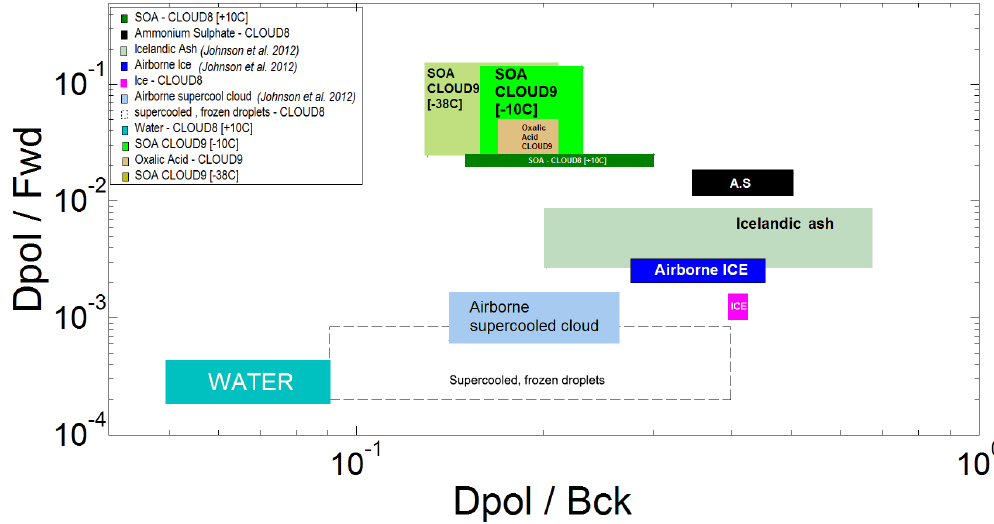
Figure 9. Atmospheric particle classification map for CLOUD data. The dimensions of the coloured rectangular boxes represent the space of measurements error and data points’ distribution. Additional CASPOL data points from aircraft measurements are presented for comparison (Johnson et al.,